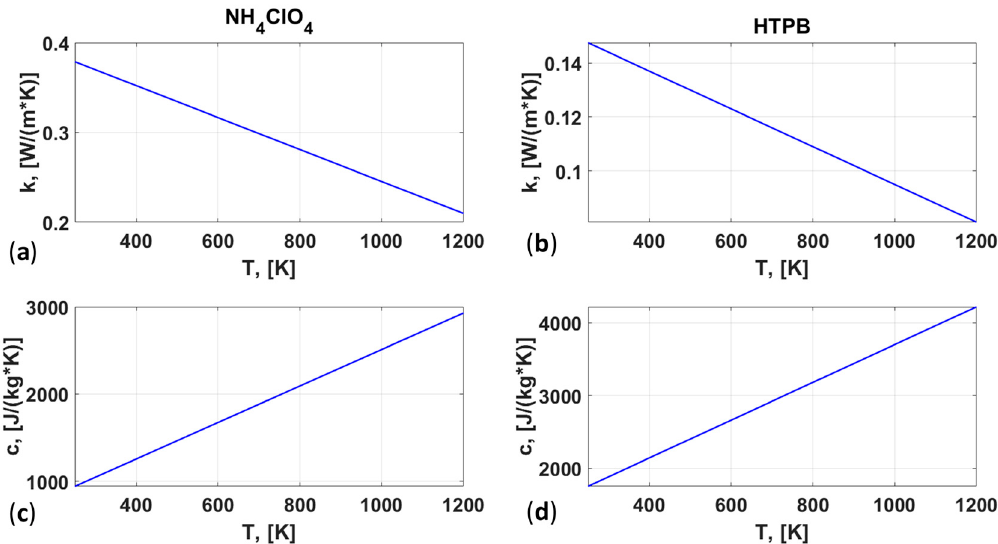
Figure 14. Temperature-varying curves of thermal conductivity and specific heat corresponding to to NH 4 ClO 4 and HTPB [35]: ( a ) thermal conductivity of NH 4 ClO 4 vs. temperature; ( b ) thermal 𝑁𝐻 (cid:2872) 𝐶𝑙𝑂 (cid:2872) and 𝐻𝑇𝑃𝐵 [35]: ( a ) thermal conductivity of 𝑁𝐻 (cid:2872) 𝐶𝑙𝑂 (cid:2872) vs temperature; ( b ) thermal conductivity of HTPB vs. temperature; ( c ) specific heat of NH 4 ClO 4 vs. temperature; ( d ) specific conductivity of 𝐻𝑇𝑃𝐵 vs temperature; ( c ) specific heat of 𝑁𝐻 (cid:2872) 𝐶𝑙𝑂 (cid:2872) vs temperature; ( d ) specific heat heat of HTPB vs. of 𝐻𝑇𝑃𝐵 vs temperature.